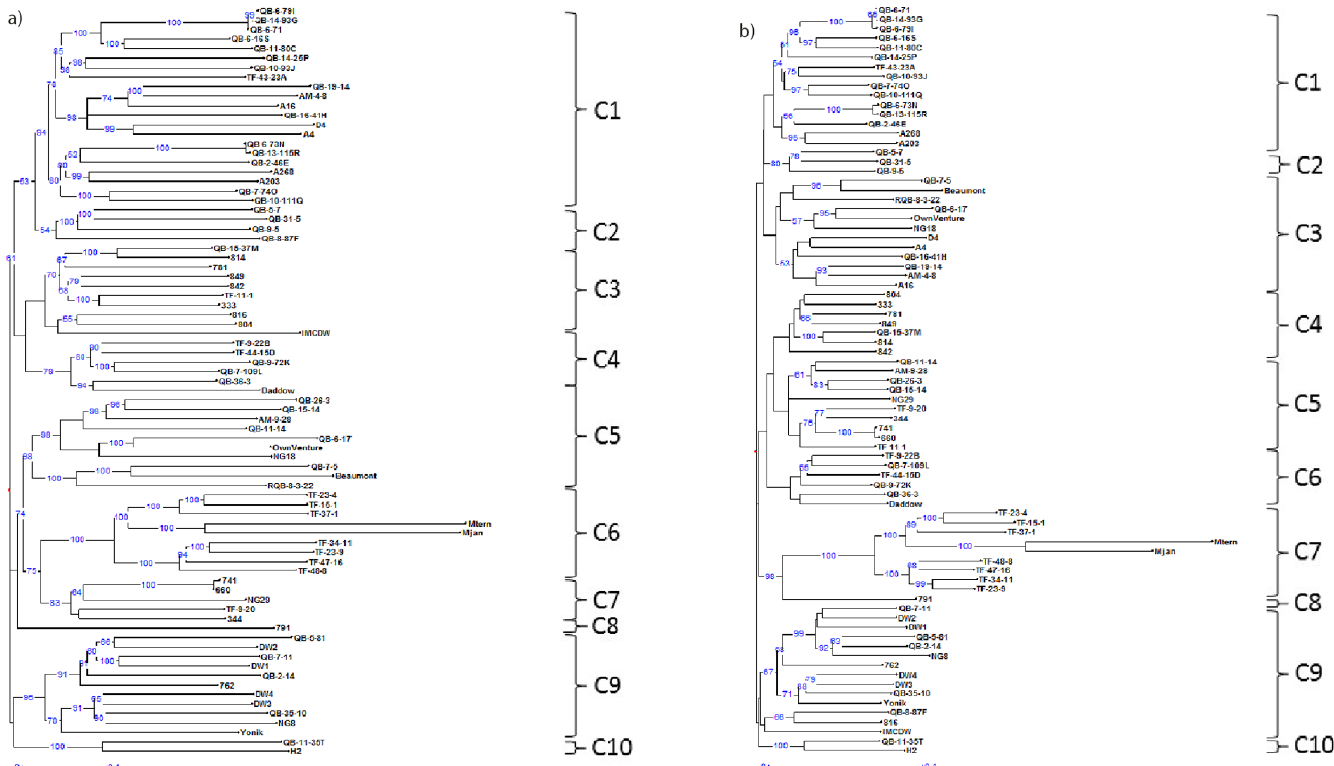
Fig 3. Genetic relationships among 80 macadamia accessions, and 7 biological and 21 technical replicates. (a) Weighted neighbour-joining dendrogram based on silicoDArT markers. (b) Weighted neighbour-joining dendrogram based on SNP markers.